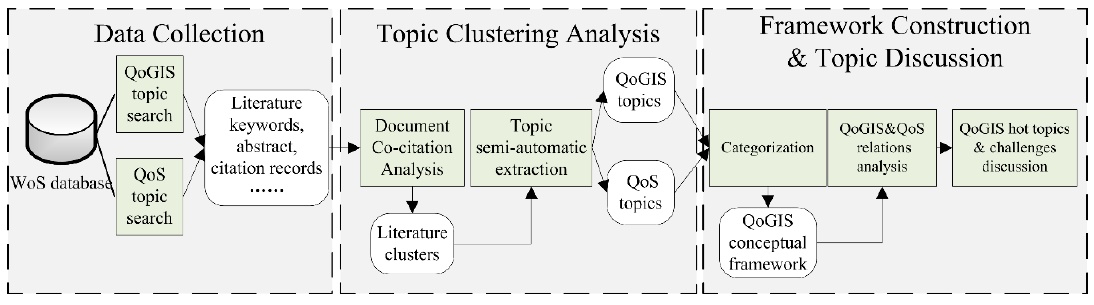
Figure 1. Research workflow.